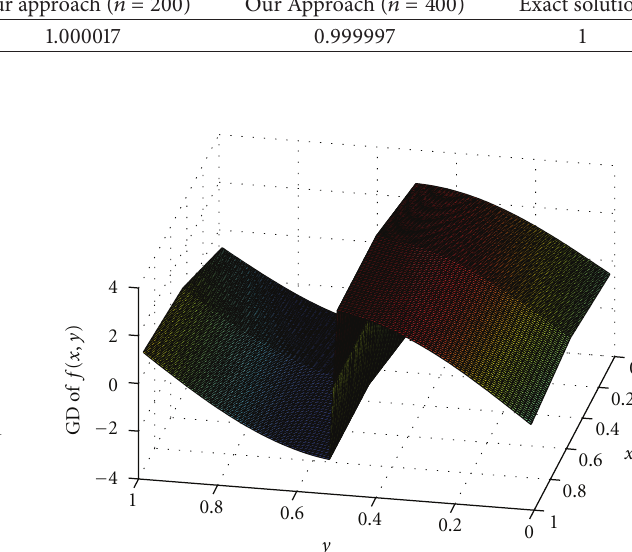
Figure 5: The graph of function 𝑓(⋅,⋅) of Example 3.